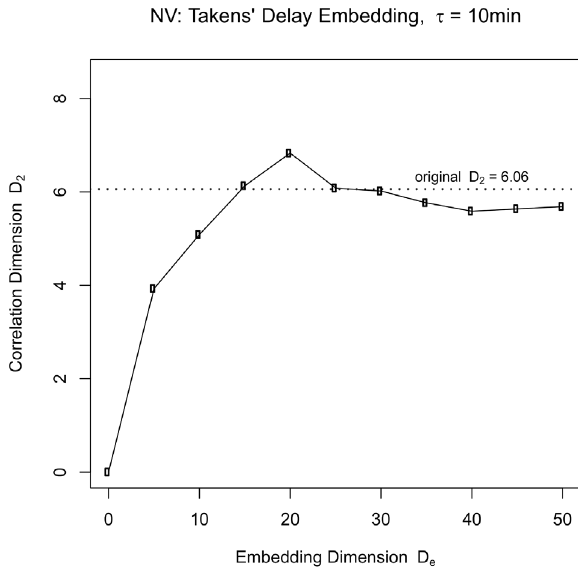
Figure 4. Takens’ delay embedding procedure: Recovery of the lower scale correlation dimension estimate for NV’s images. A time delay of t =10 minutes was used to construct the delay embedded vectors at each value of embedding dimension. As the embedding dimension is increased, the correlation dimension of the reconstructed delay embedded vectors asymptotes to the original lower scale estimate of 6.06.